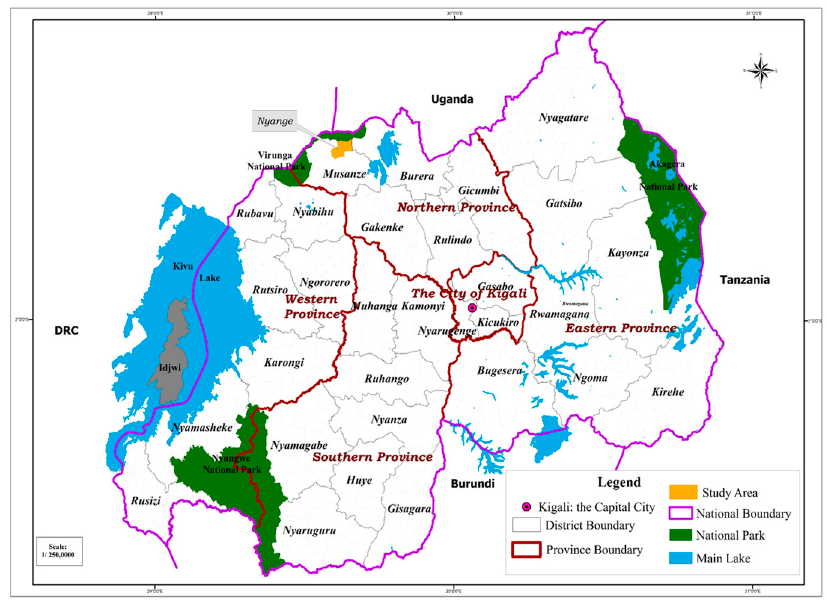
Figure 4. Nyange sector (case study) location in Rwanda.